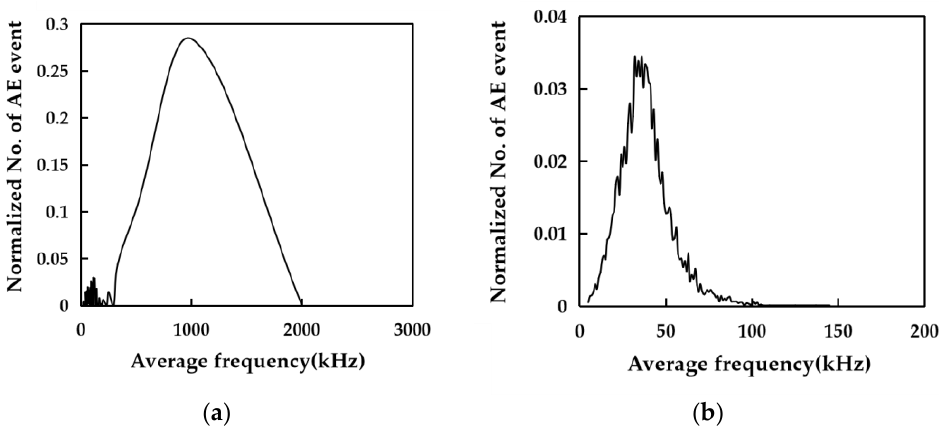
Figure 14. Average frequency distribution: ( a ) cluster 1; ( b ) cluster 3.